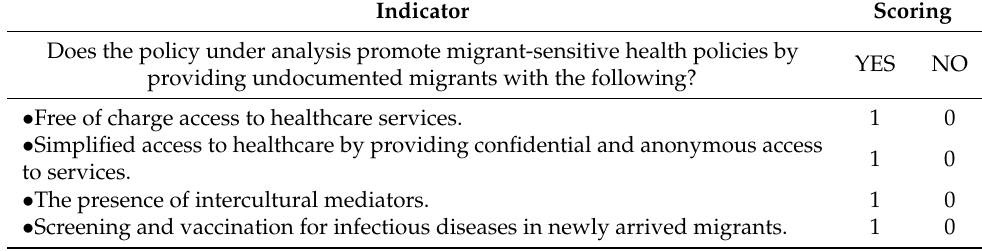
Table 3. Indicator 3. Indicator